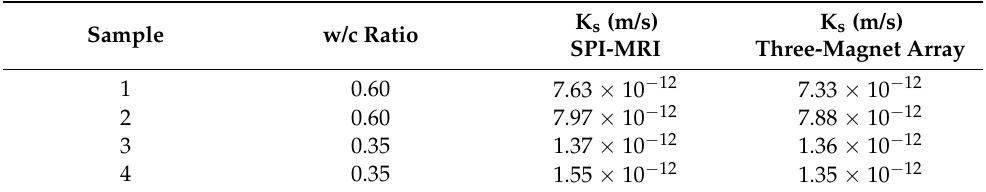
Figure 7. Experimental and fitted moisture distribution profiles of a 0.60 w/c ratio mortar sample. The experimental profiles were acquired with the three-magnet array and the SPI T 2 * mapping MRI technique. Fitted profiles were obtained by inverse modeling with the Hydrus software. Table 2. K s values of the 0.60 and 0.35 w/c ratio mortars, obtained from inverse modeling using the Hydrus